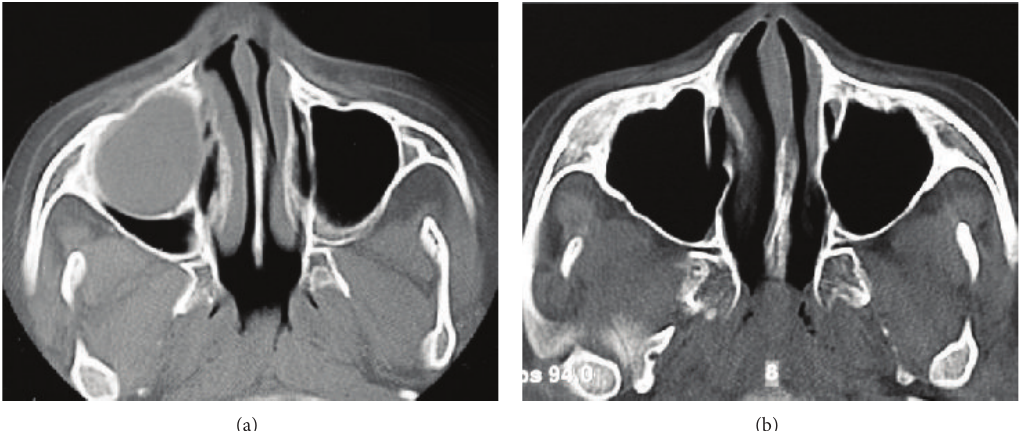
Figure 2: CT axial images showing opacity of the right maxillary sinus in the diagnostic phase (a); maxillary sinus cleared after 3 months of treatment (b).